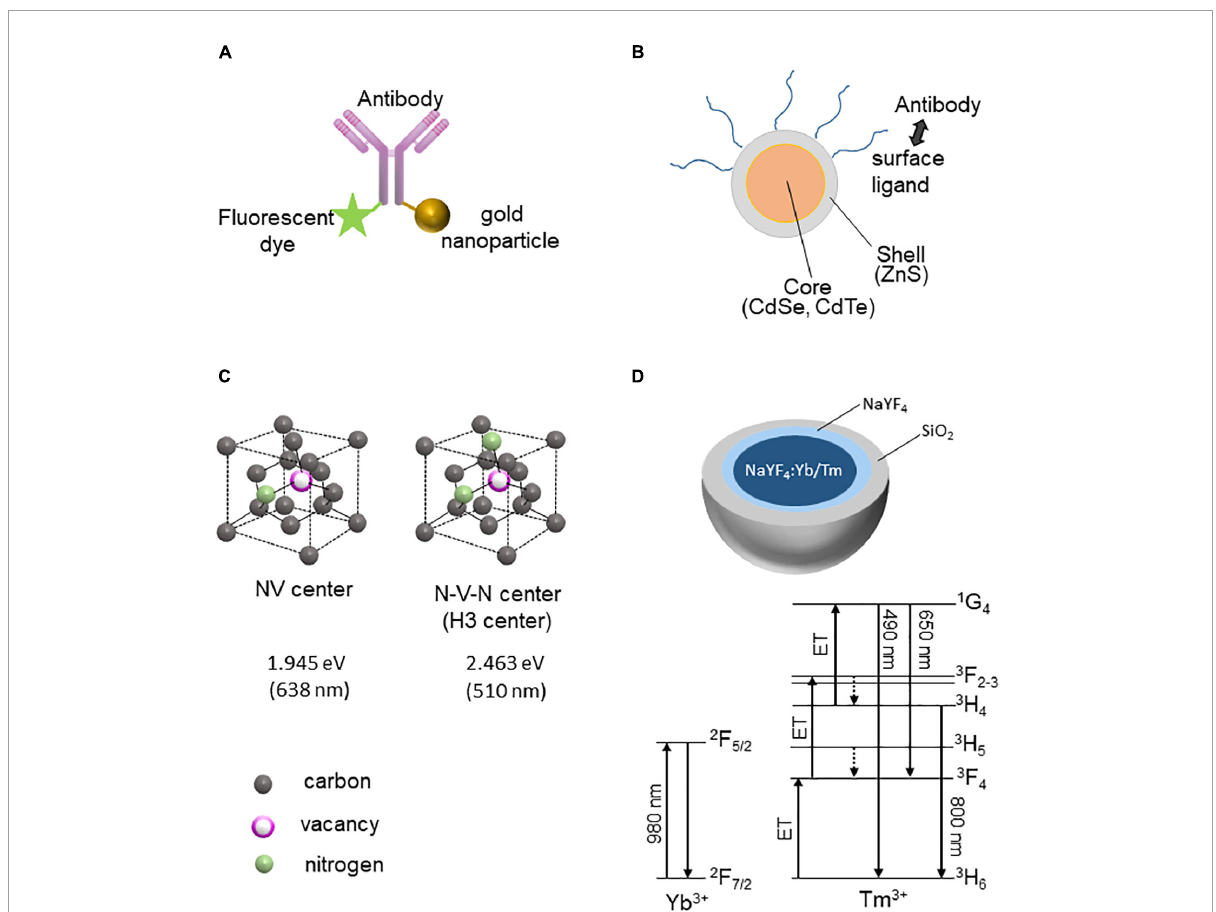
FIGURE1 Fluorescent nanoprobes for CLEM. (A) FluoroNanogold structure: The gold nanoparticle and fluorescent dye are conjugated with the antibody (IgG or Fab fragment). (B) Quantum dot (Qdot) structure: Antibodies can be conjugated with Qdot via its surface ligands. (C) Crystallographic structures of NV and H3 (N–V–N) centers of fluoronanodiamonds. The energies and corresponding wavelengths of FNDs are shown (attributed to the zero-phonon lines). (D) Structure of upconversion nanoparticles with rare-earth ions (NaF 4 :Yb/Tm). The Jablonski diagrams of Yb 3 + and Tm 3 + are shown